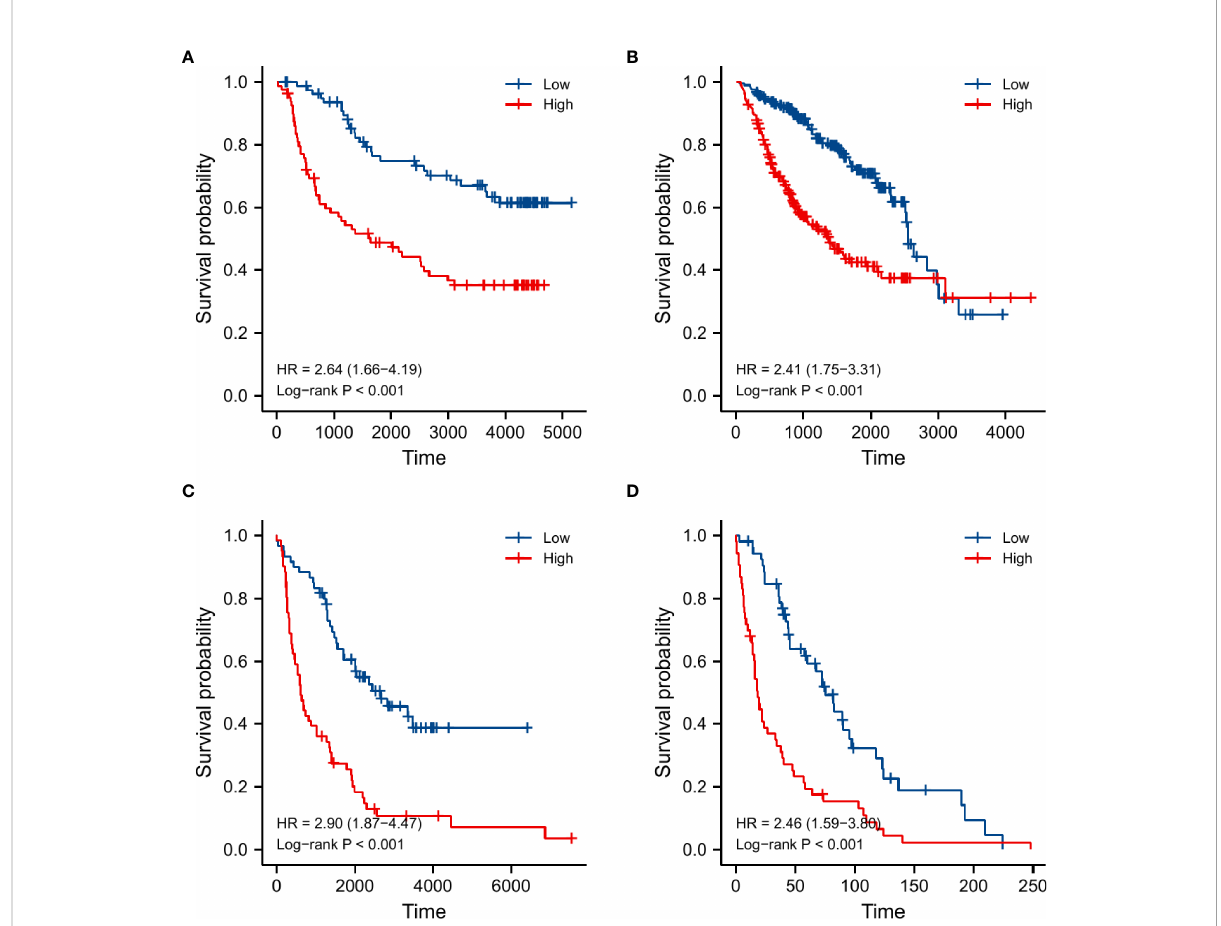
FIGURE 10 Kaplan-Meier curves and log-rank tests used for survival analyses between low and high risk groups in different validation datasets. (A) CGGA microarray dataset, (B) CGGA sequencing dataset, (C) REMBRANDT cohort, (D) GSE16011